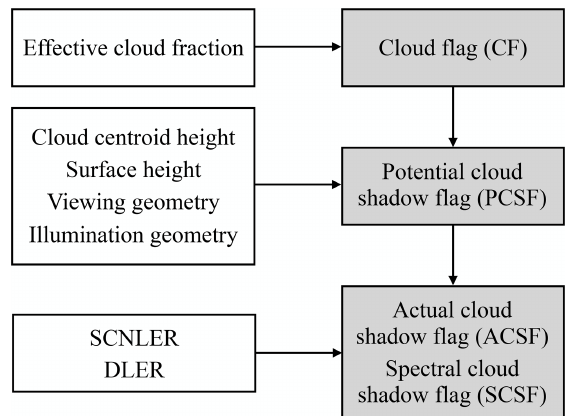
Figure 1. Summary of the inputs and outputs of DARCLOS. The white boxes describe the main input data, and the grey boxes de- scribe the calculated output products. SCNLER refers to the reflec- tivity of the scene (Sect. 2.2.1), and DLER refers to the climatolog- ical directionally dependent surface reflectivity (Sect. 2.2.2). More details are provided in the main